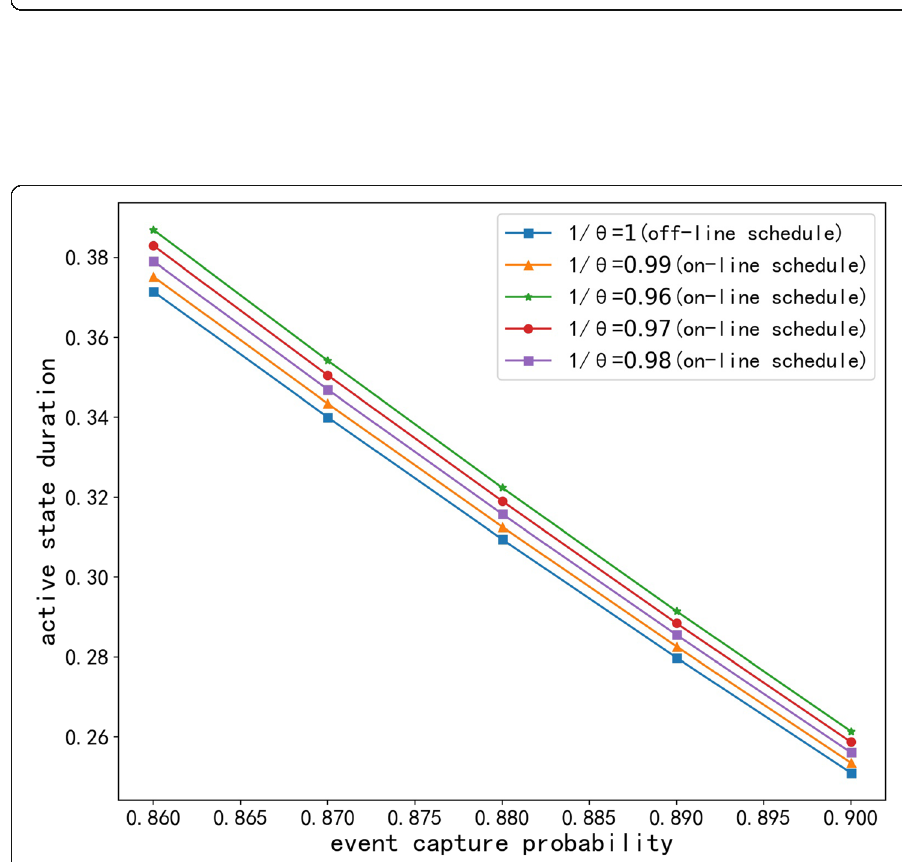
Fig. 3 Effect of event capture probability on active state duration in different scheduling